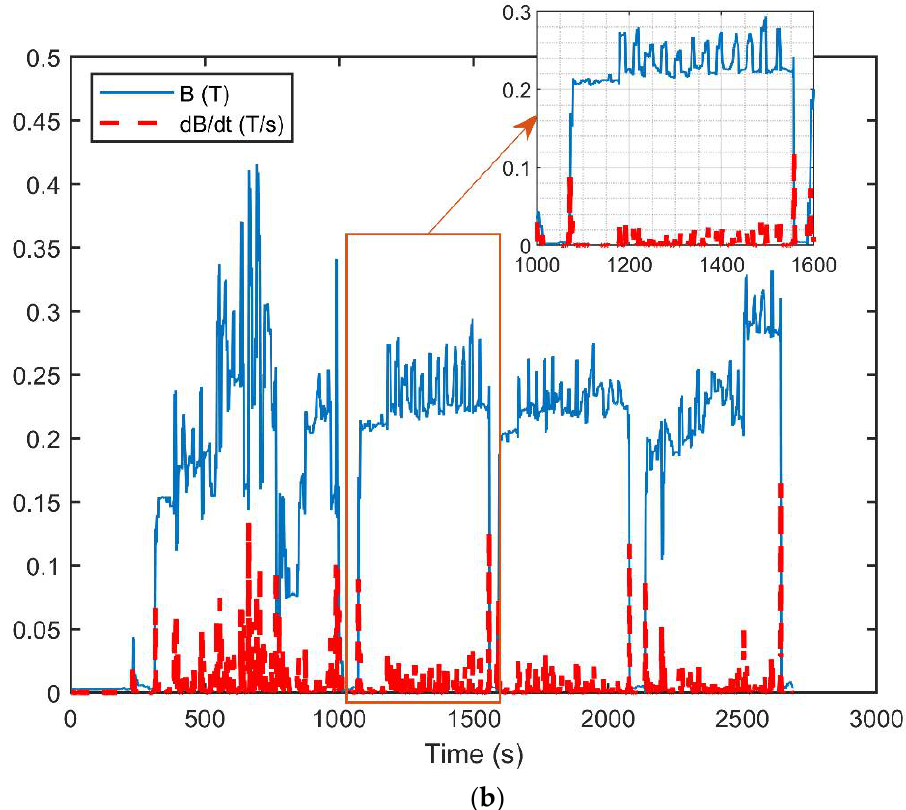
Figure 2. Magnetic flux density B together with its time derivative dB/dt experienced by: ( a ) a maintenance technician during oxygen sensor replacement, ( b ) a researcher during fMRI protocol.